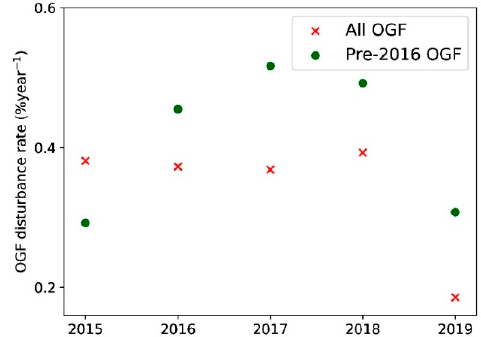
Figure 8. Annual disturbance of old growth forest (OGF) in the Ukrainian Carpathians (red: rate of disturbance of all OGF surveyed by the year of disturbance, green: rate of disturbance of OGF surveyed in 2015 or earlier).